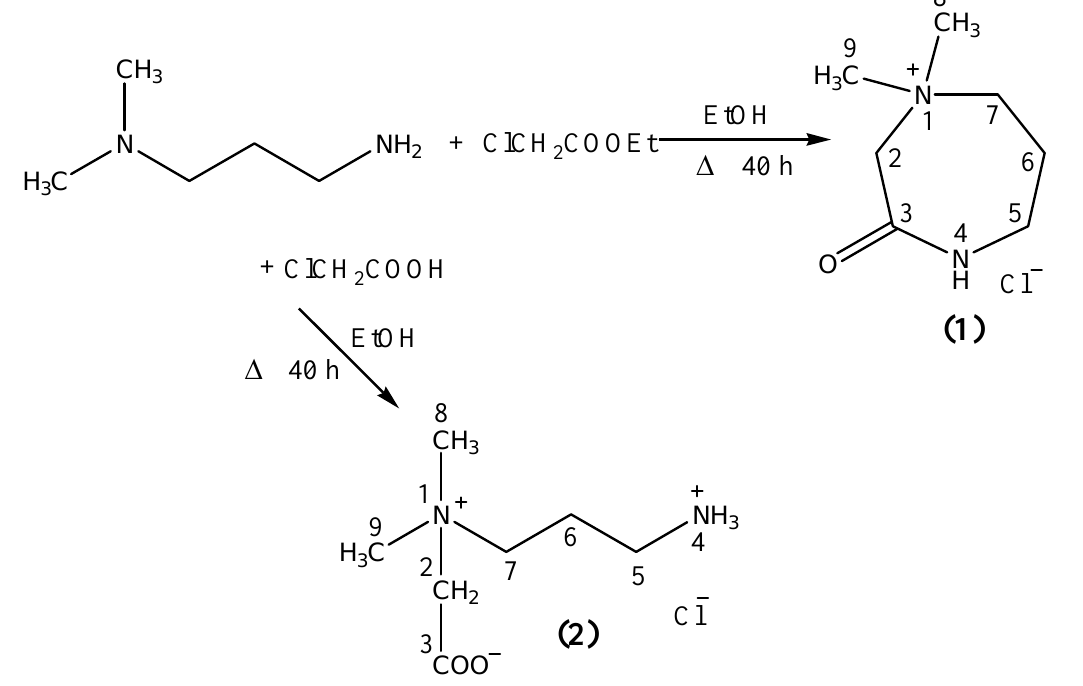
Scheme 1 . Synthesis of 1,1-dimethyl-3-oxo-1,4-diazepan-1-ium chloride ( 1 ) and 1,1-